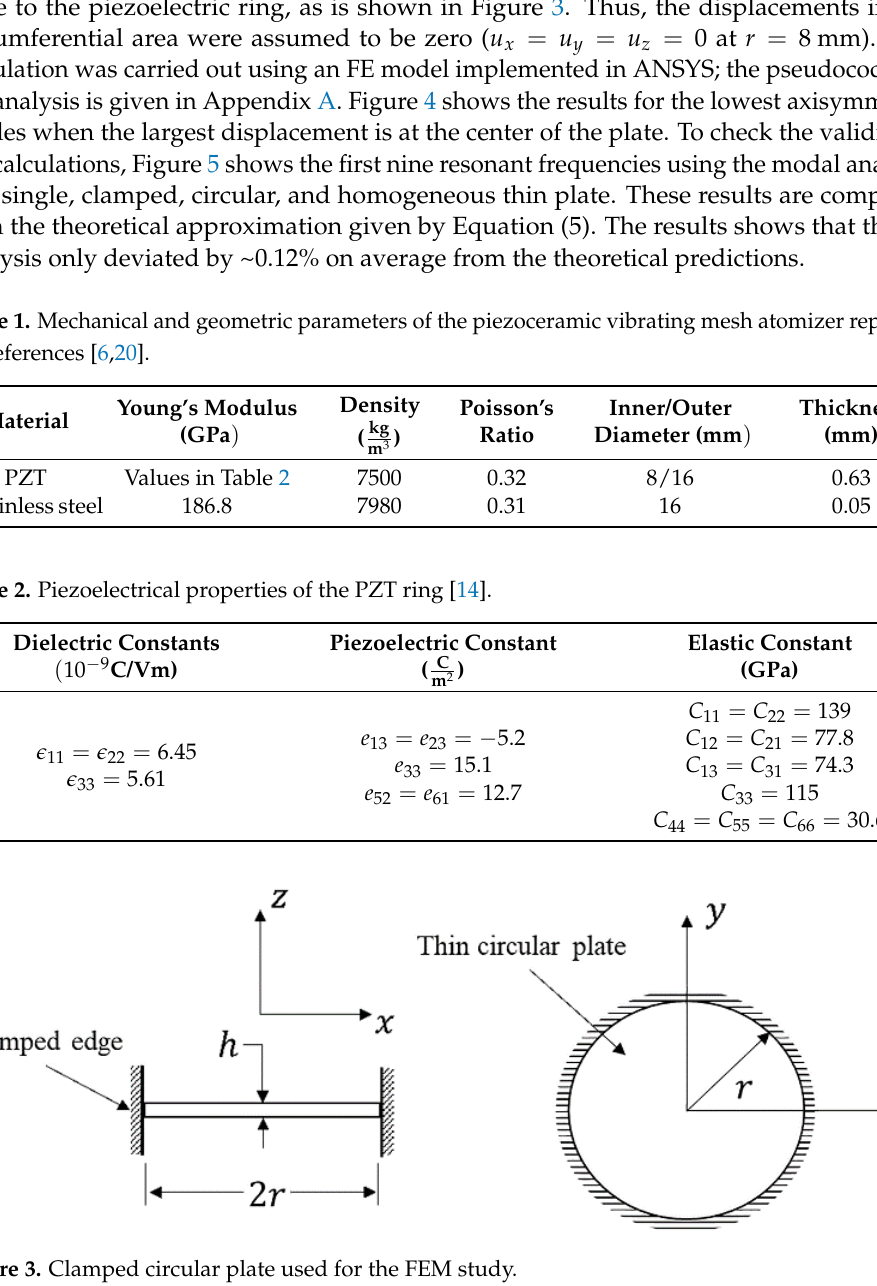
Figure 4. ( a ) Geometry used for the FEM modal analysis. ( b – d ) Contour plots of the first three ax- isymmetric vibrational modes estimated for the homogeneous thin plate.